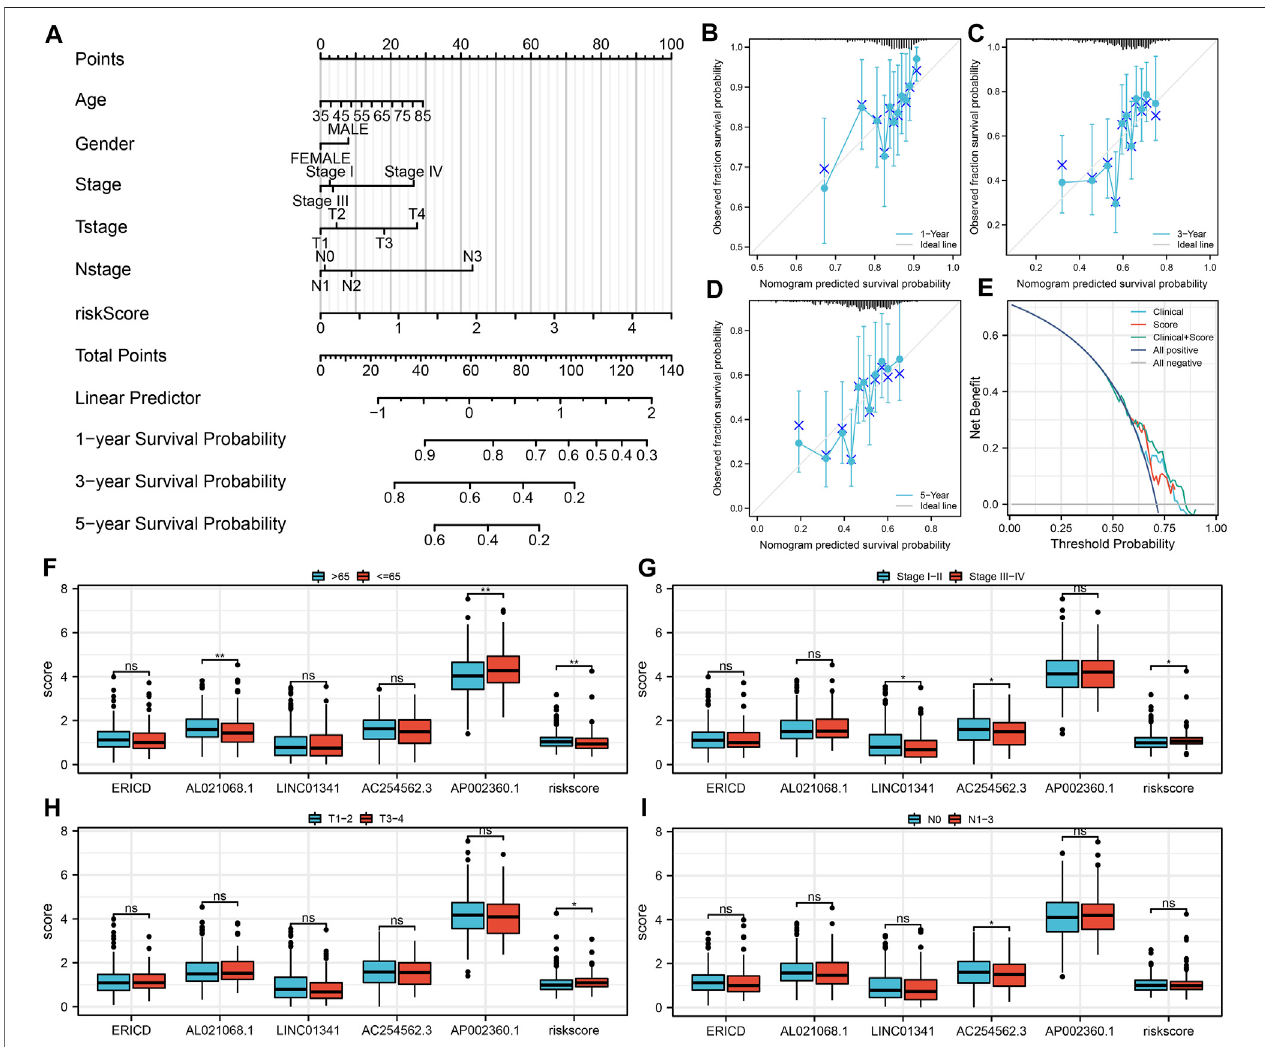
FIGURE4| Nomogramandclinicalcorrelationanalysis. (A) Nomogramwasconstructedbycombiningtheriskscoreandclinicalfeatures; (B – D) Calibrationcurves of the nomogram; (E) DCA curve of the nomogram; (F) Expression of model lncRNAs and risk score in different age groups; (G) Expression of model lncRNAs and risk score in different clinical stage groups; (H) Expression of model lncRNAs and risk score in different T classi fi cations groups; (I) Expression of model lncRNAs and risk score in different N classi fi cations groups.